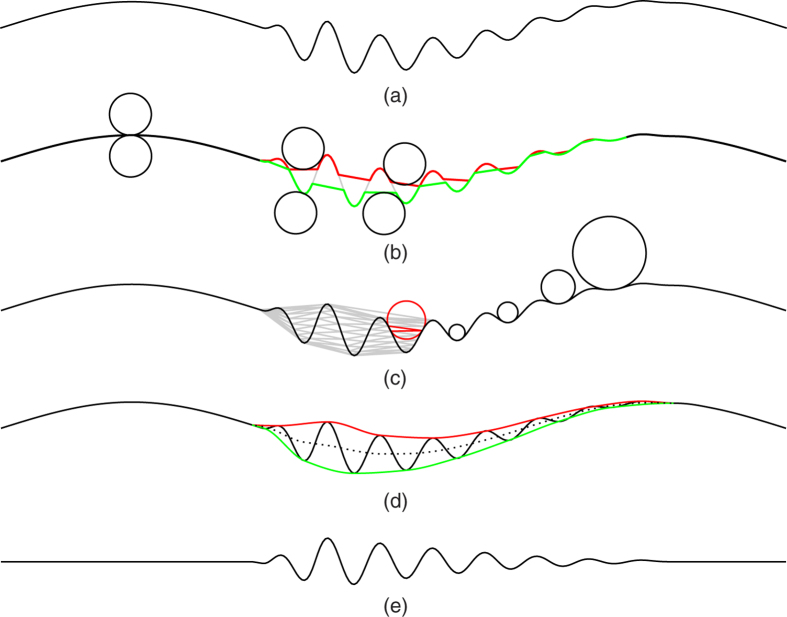
A rolling ball sifting example.(a) A simulated carotid bruit signal. (b) One ball rolling above and the other below the signal to derive “alpha shapes” as the upper (red) and lower (green) envelopes of the bruit. (c) A partial DT illustrates a circumcircle (red) for computing the tangent radius information. Four circles on the right show how the amplitude affects the tangent radius. (d) The non-overlaid envelope segments found in (b) and their neighbor oscillating waves with small amplitude are merged and inflated. (e) The bruit can be extracted by subtracting the mean (dotted line in (d)) of the upper and lower envelopes from the signal.